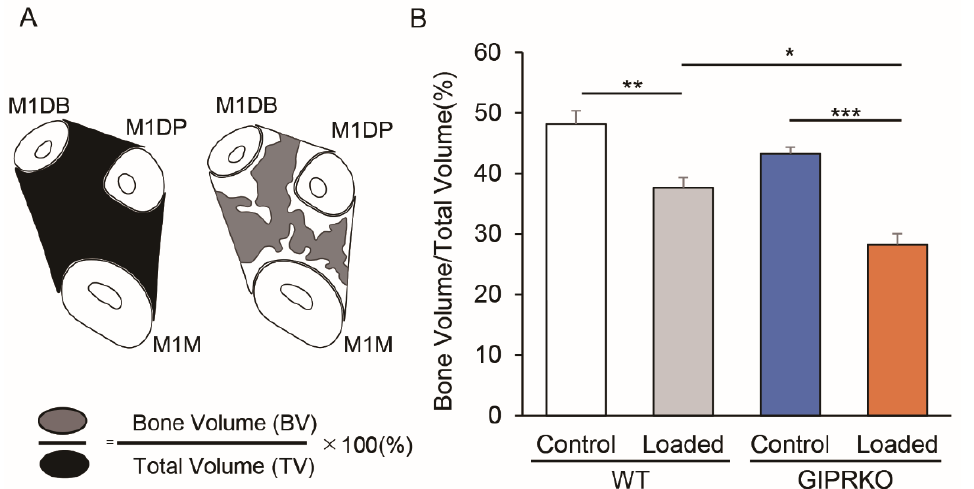
Figure 4. Alveolar bone in the inter-root septum from the root bifurcation to the apex of M1 was measured 14 days after the orthodontic tooth movement. ( A ) Schematic diagram of the horizontal cross section of the interroot septum of M1. ( B ) Comparison of bone volume/total volume (BV/TV) between M1M: M1 mesial root, M1DP: M1 centrifugal palatal root, M1DB: M1 centrifugal buccal root in the control and the loaded side in WT and GIPRKO (* p < 0.05, ** p < 0.01, *** p < 0.001) (WT: n = 5, GIPRKO: n = 4).